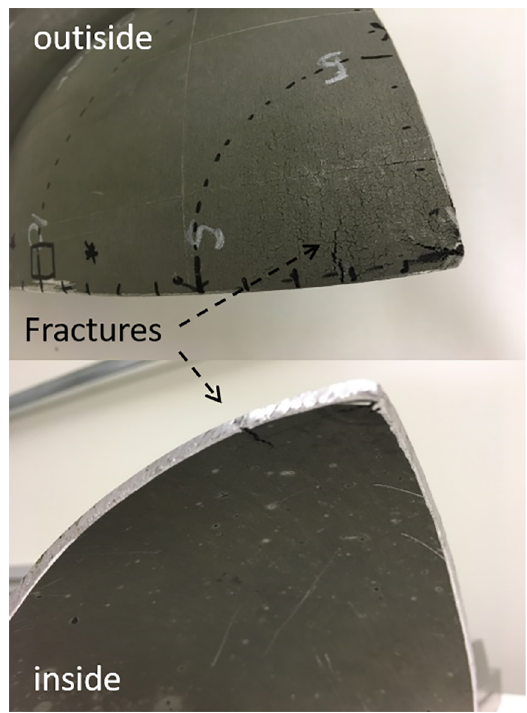
Figure 14. Cross section of the dome performed without back pressure.